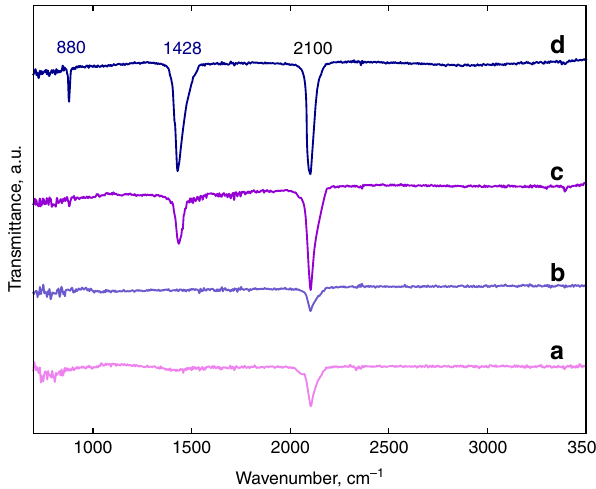
Fig. 2 ATR-FTIR spectra of the samples before and after plasma reaction. Spectra a , c are taken from pure NaN 3 without carbon nanotube support before and after plasma reaction, respectively; and spectra b , d are from plasma-reacted NaN 3 deposited on short MWNTs before and after plasma reaction, respectively. The IR-active modes for NaN 3 are the bending ν 2 mode of the azide ion at 638 cm − 1 (not shown here) and the anti- symmetric stretching ν 3 mode of the azide ion at 2100 cm −